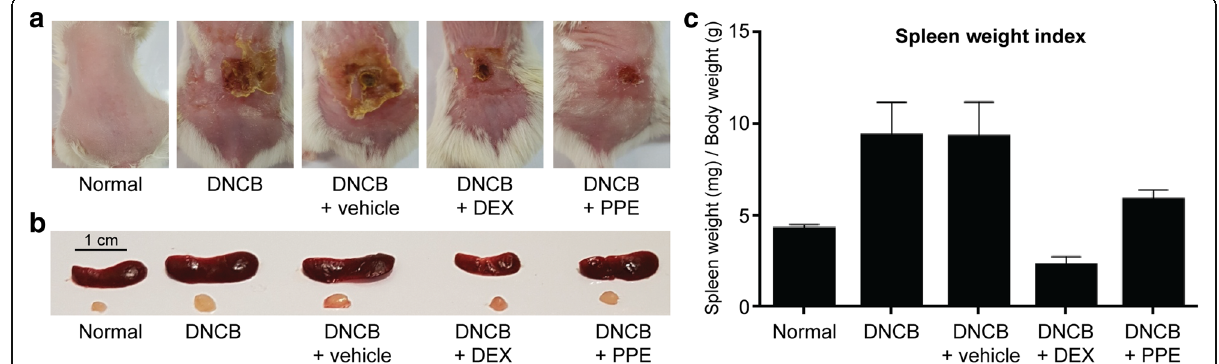
Fig. 2 Establishment of a DNCB-induced contact dermatitis mouse model and evaluation of the anti-inflammatory effect of PPE. ( a ) Representative images depicting contact dermatitis-like symptoms. Repeated application of DNCB-treated patches on back skin of mice was sufficient to trigger skin inflammation resembling contact dermatitis. Co-treatment with PPE or DEX led to a significant reduction in the clinical severity. ( b ) Size comparison of spleen (upper panels) and draining lymph node (lower panels) with or without PPE treatment. Spleens and lymph nodes were isolated from all mouse groups on day 17. Treatment with DNCB alone or DNCB in vehicle (cream) led to an increase in both spleen and lymph node sizes. Application of either PPE or DEX inhibited enlargement of these immune organs. ( c ) Comparison of spleen weights as an inflammation index. The spleen weight of each mouse group was normalized to body weight ( n = 3 for each